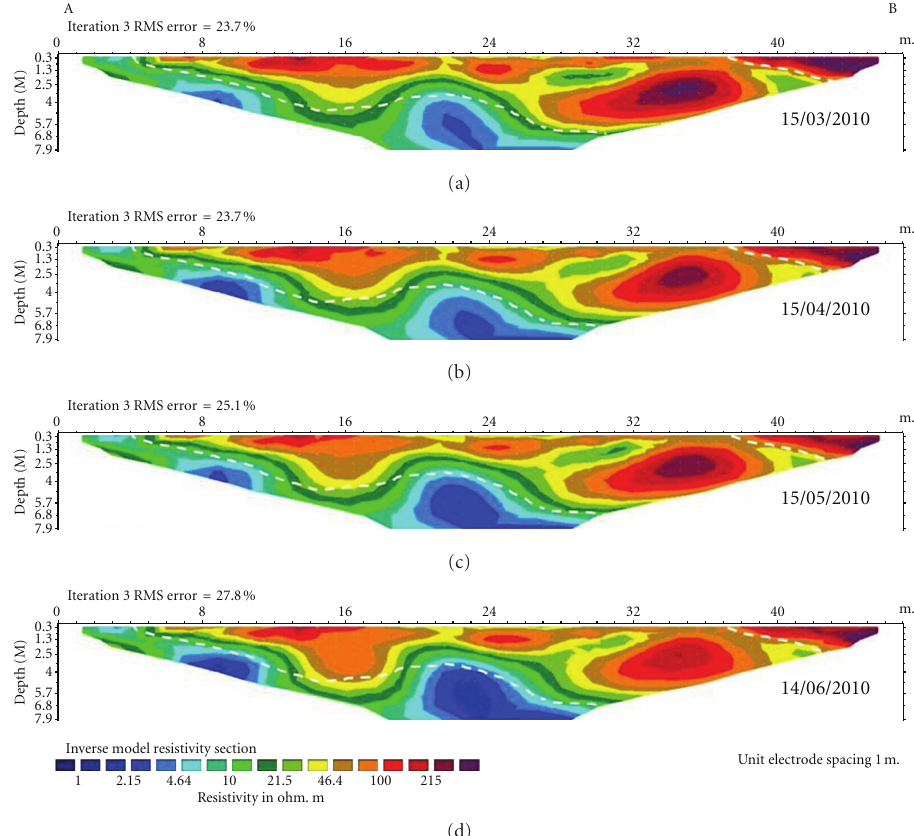
Figure 11: ERT performed in di ff erent days with an interval of one month; it is possible to observe the low change in resistivity during all the studied